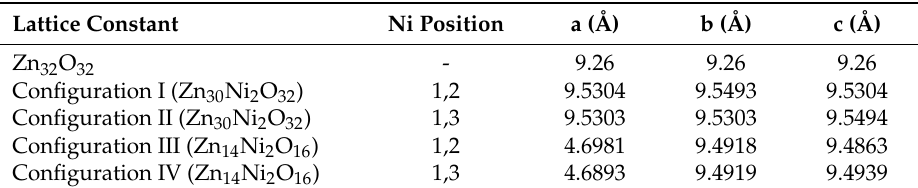
Table 1. Lattice constant of Ni-doped zinc-blende (ZB) ZnO.